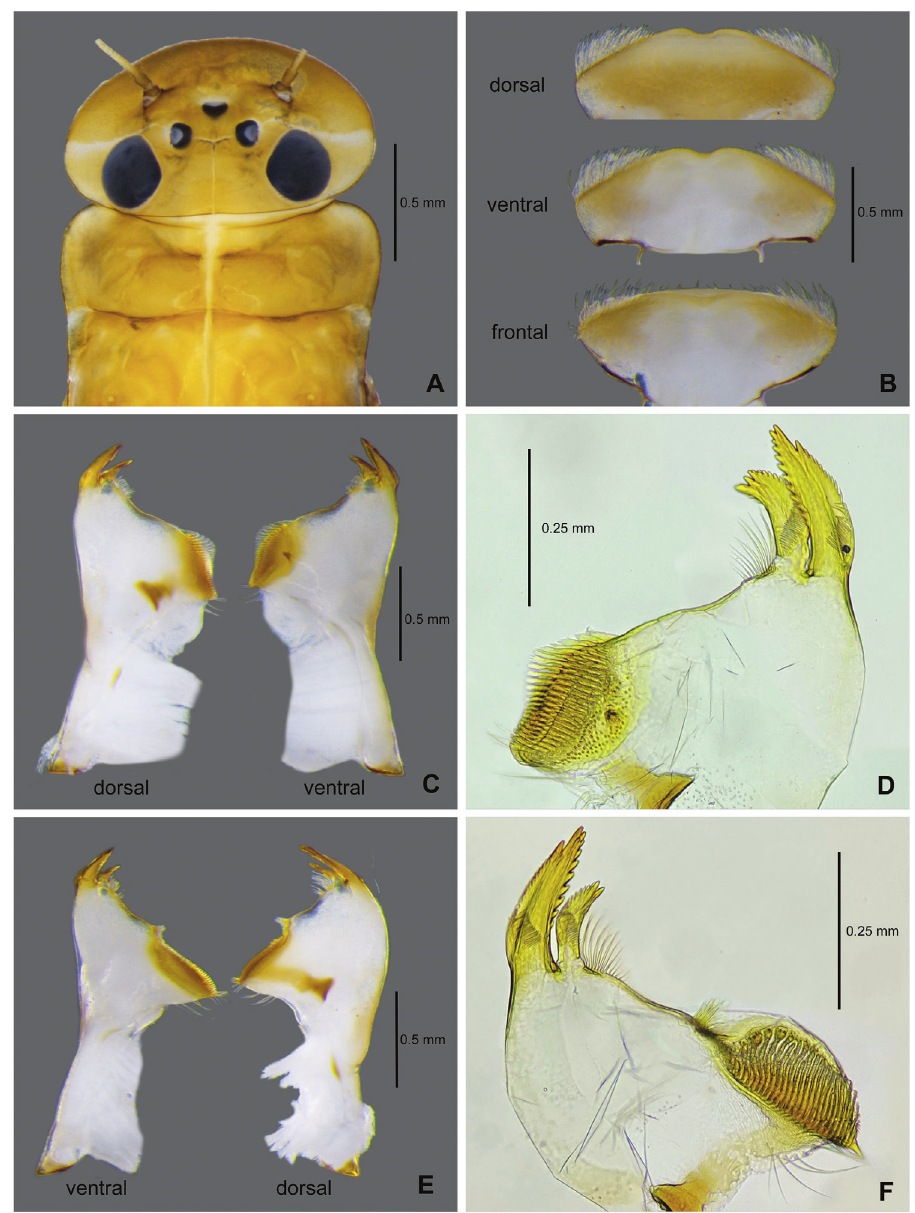
Figure 2. Paegniodes sapanensis sp. nov., larval morphology A head and pronotum B labrum C left mandible D enlargement of left mandible (ventral view) E right mandible F enlargement of right mandible (ventral Left mandible (Fig. 2C). Outer and inner incisors acute with serrated margins, row of bristles located near inner incisor, row of fine serrated spines locate on base of outer and inner incisors, margin between inner incisor and mola slightly concave and